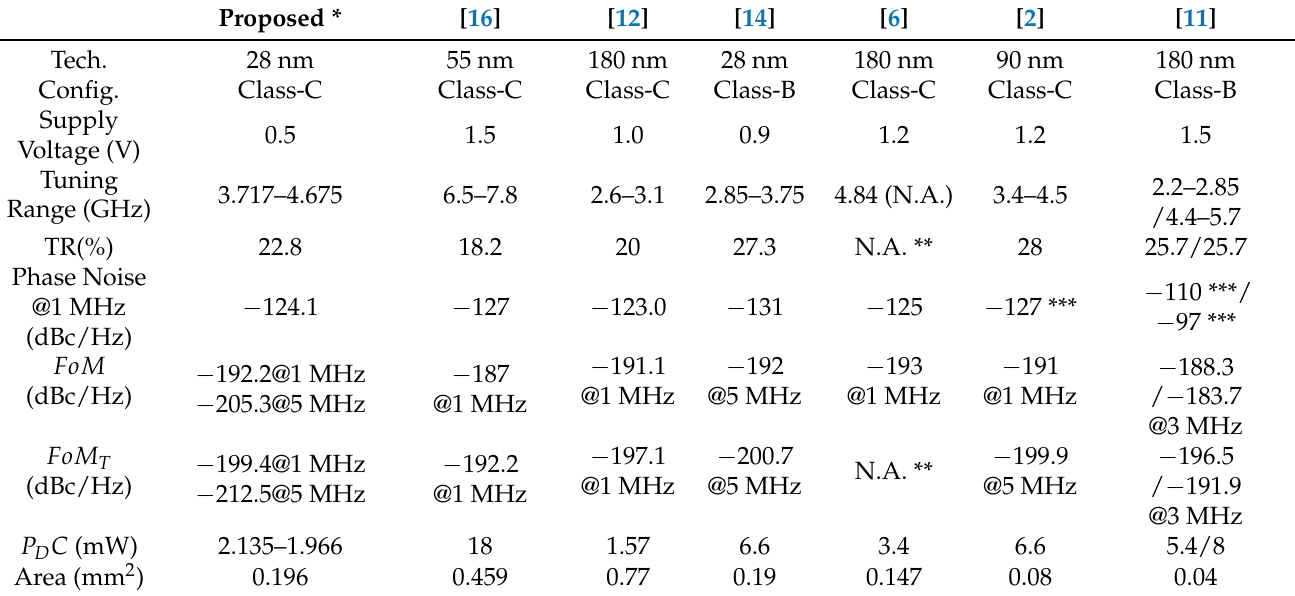
Table 2. Performance comparison table among recently published state-of-art CMOS